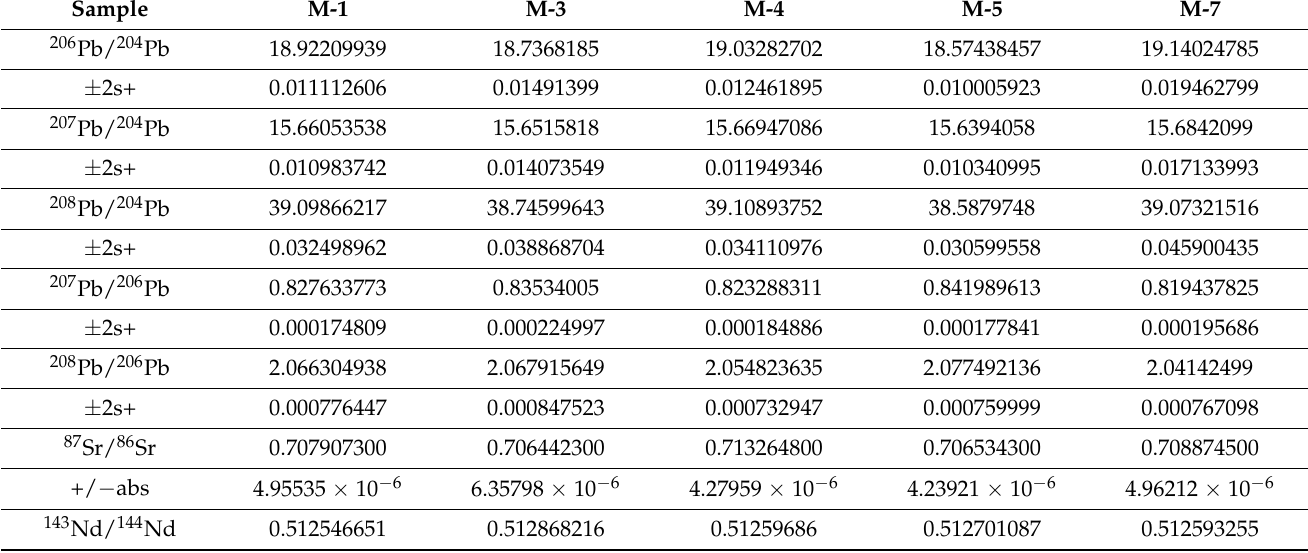
Table 8. Sr, Nd, and Pb isotope analytical data from the studied